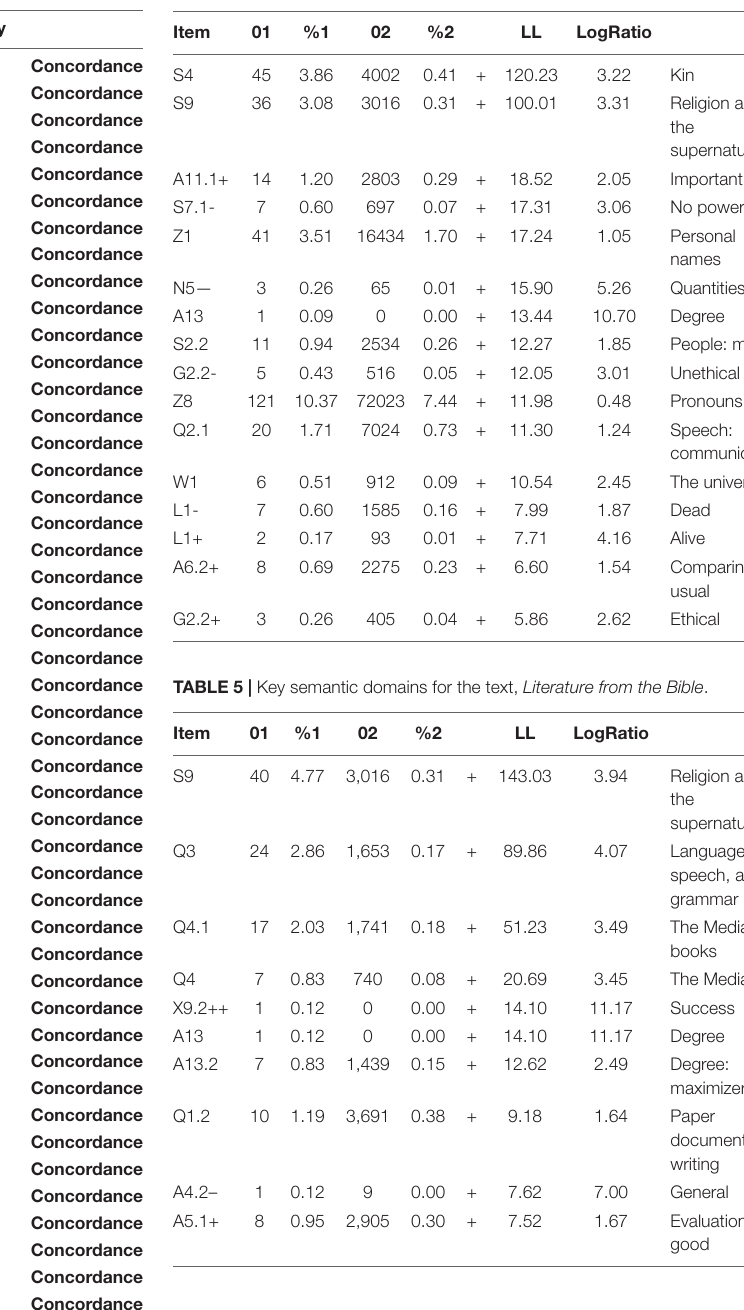
TABLE 4 | Key semantic domains for the text, Holy Family Values .